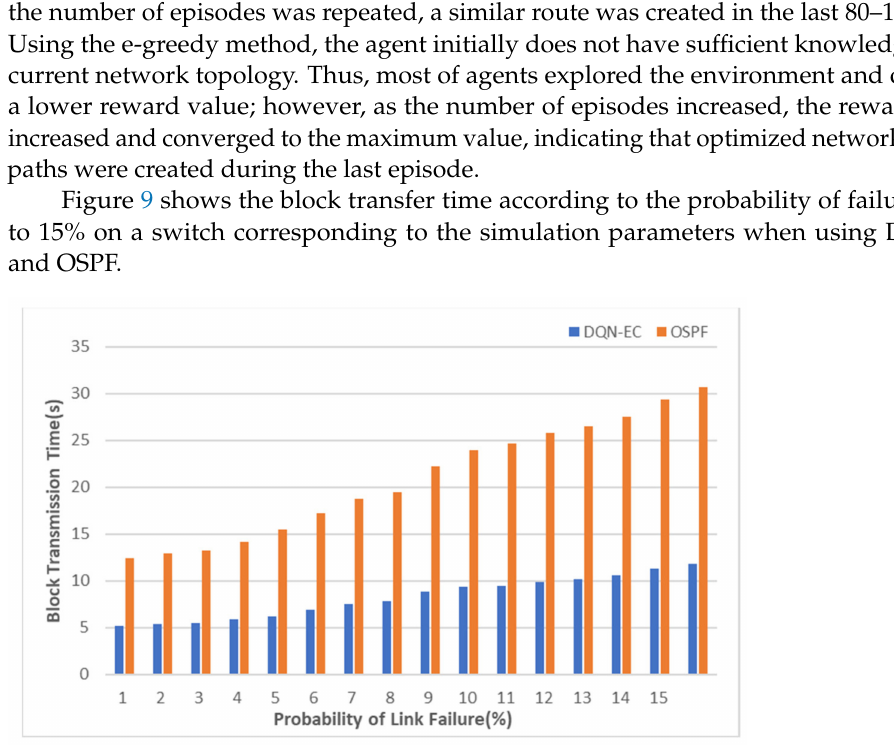
Figure 9. Block transmission time based on the probability of a link